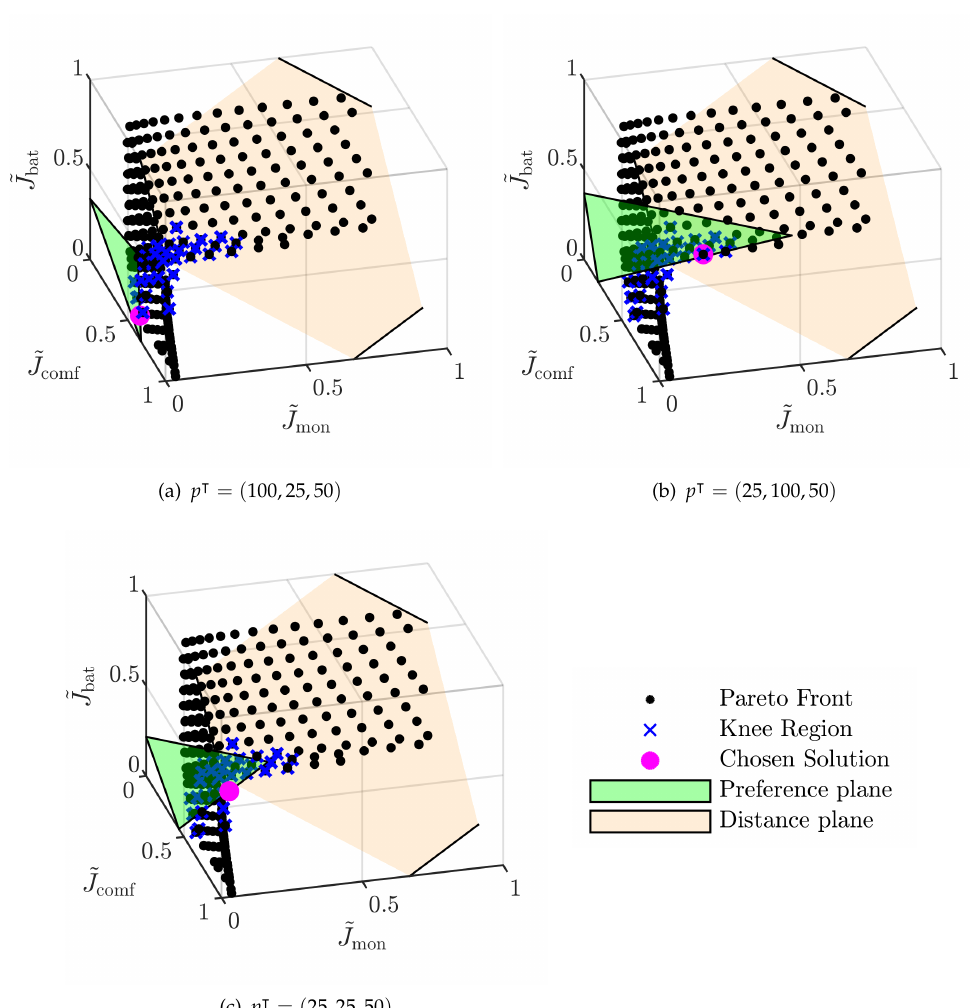
Figure 11. Single Pareto front from simulation with its knee region ( r lim = 0.85) and different preference planes with focus on ( a ) monetary, ( b ) comfort and ( c ) battery costs. Note that the different preferences are according to the extreme cases from Figure